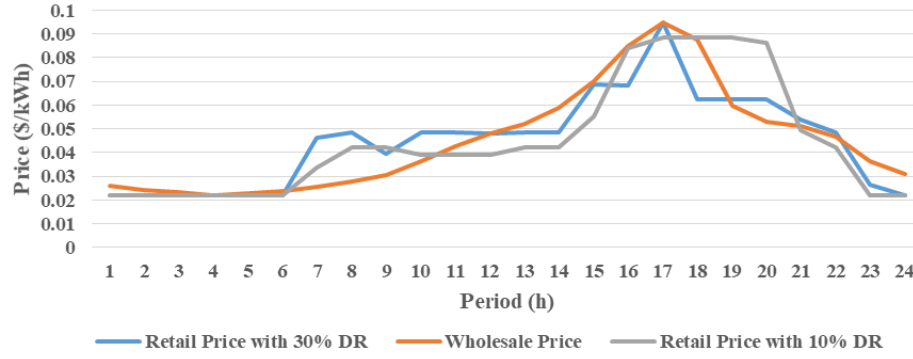
Figure 13. Retailer’s prices and its purchased prices from the wholesale